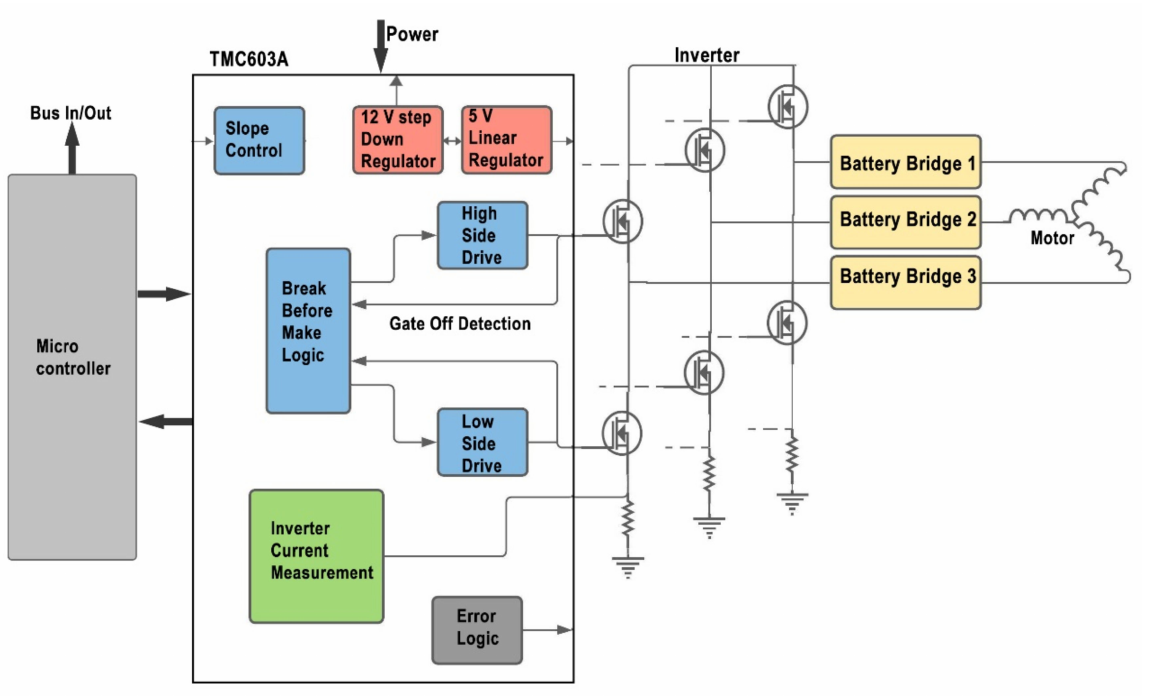
Figure 10. BLDC motor with the controller board and battery